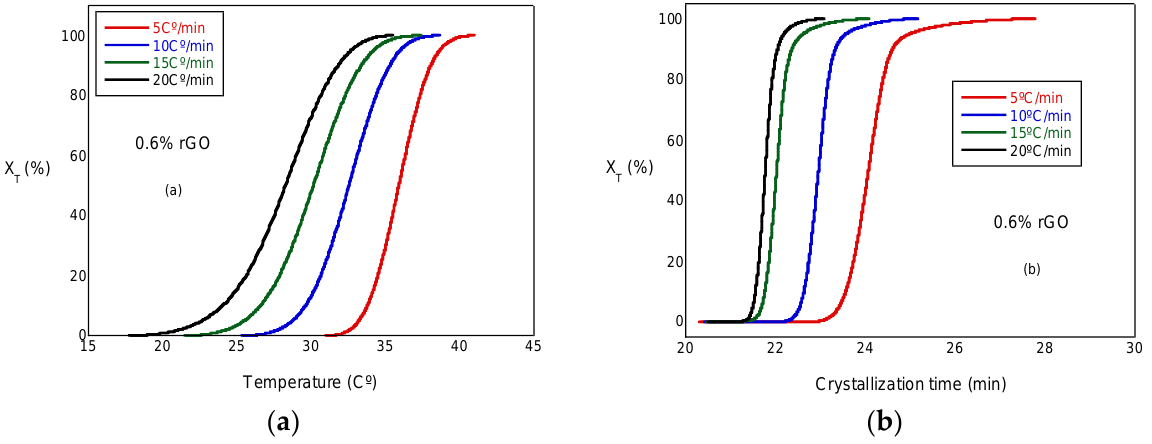
Figure 5 . ( a ) Plots of relative crystallinity versus temperature for PCL/0.6% rGO. ( b ) Plot of relative crystallinity versus crystallization time for PCL/0.6% rGO.